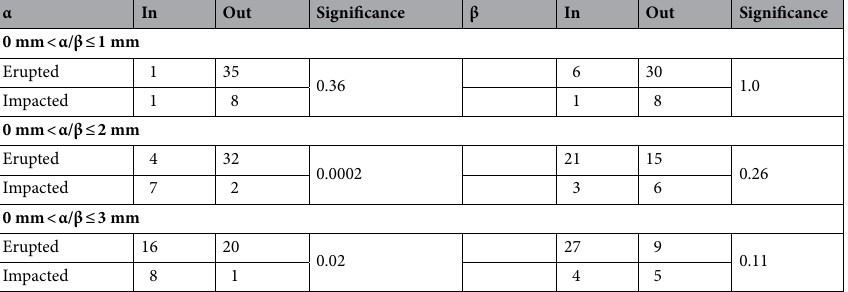
Table 1. Distance between the cusp tips of the cleft side canine and the lateral cleft margin at pre-ABG. α The shortest distance between the lateral cleft margin and the cleft side cusp tips of a canine, β The shortest distance between the lateral cleft margin and the cleft side maximum counter of a